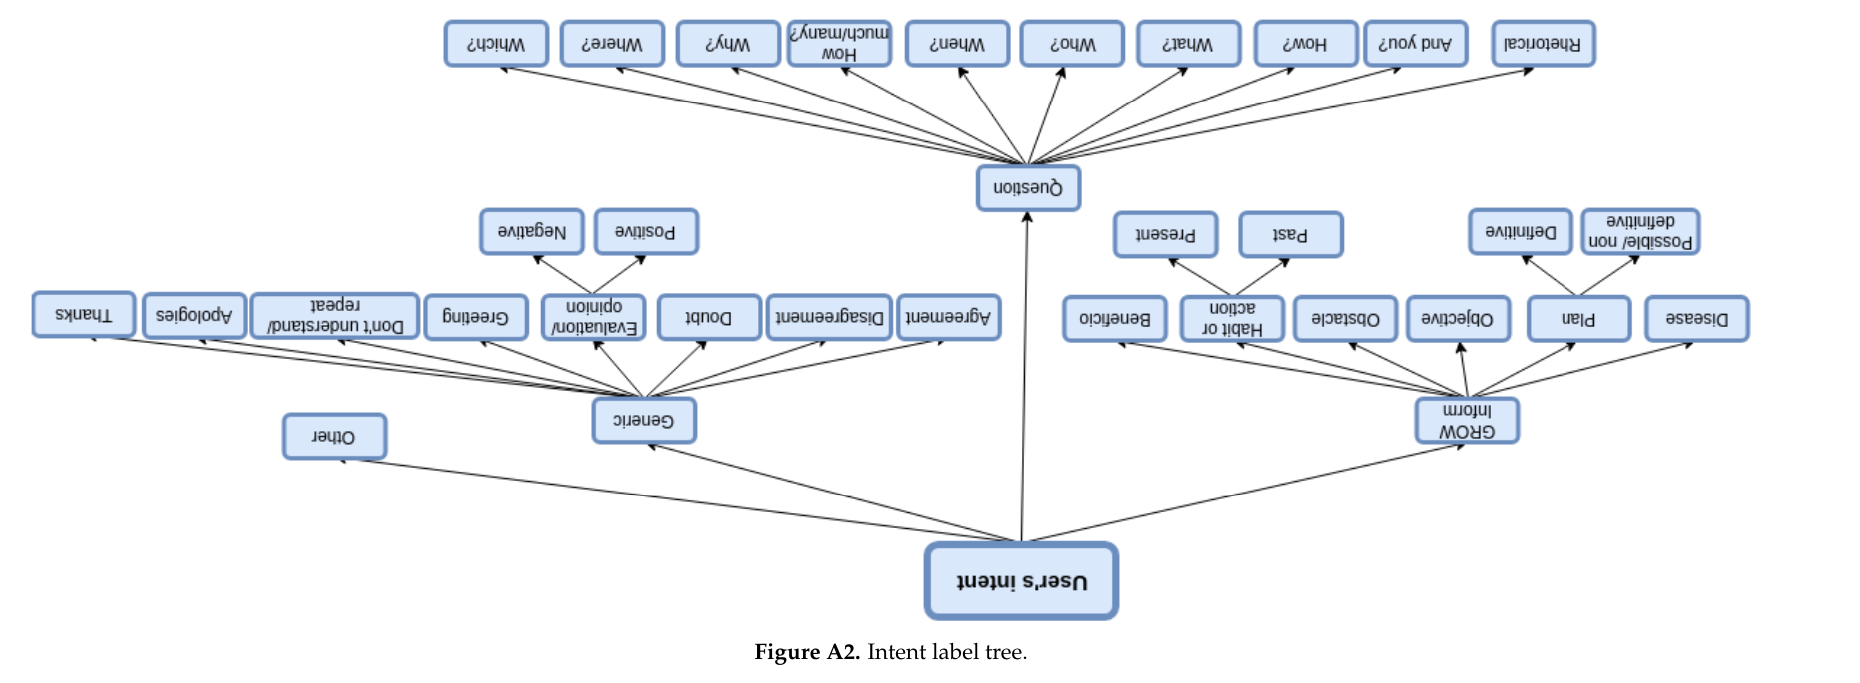
Figure A2. Intent label